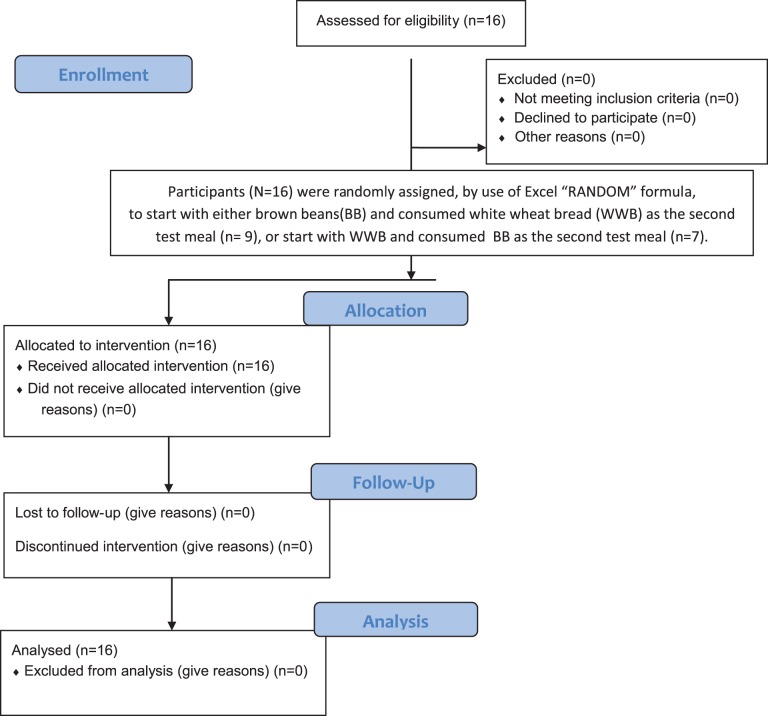
CONSORT flowchart, flow diagram of the study progress.